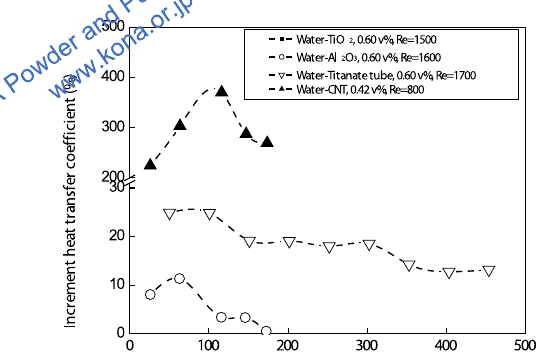
Fig. 8 Enhancement of forced convective heat transfer coefficient as a function of axial position from the inlet of the test section: carbon nanotube (CNT) and alumina nanofluids tested in the rig as shown in Fig 7(a) ; titanate and titania nanofluids measured with the system shown in Fig 7(b) .